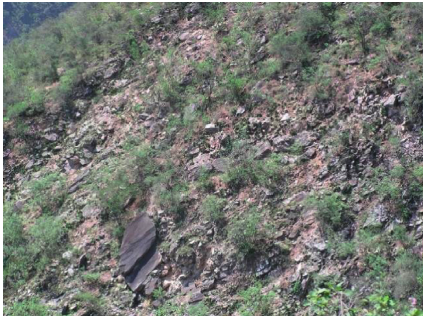
Figure 6: Composition of the front of the sliding mass in partition